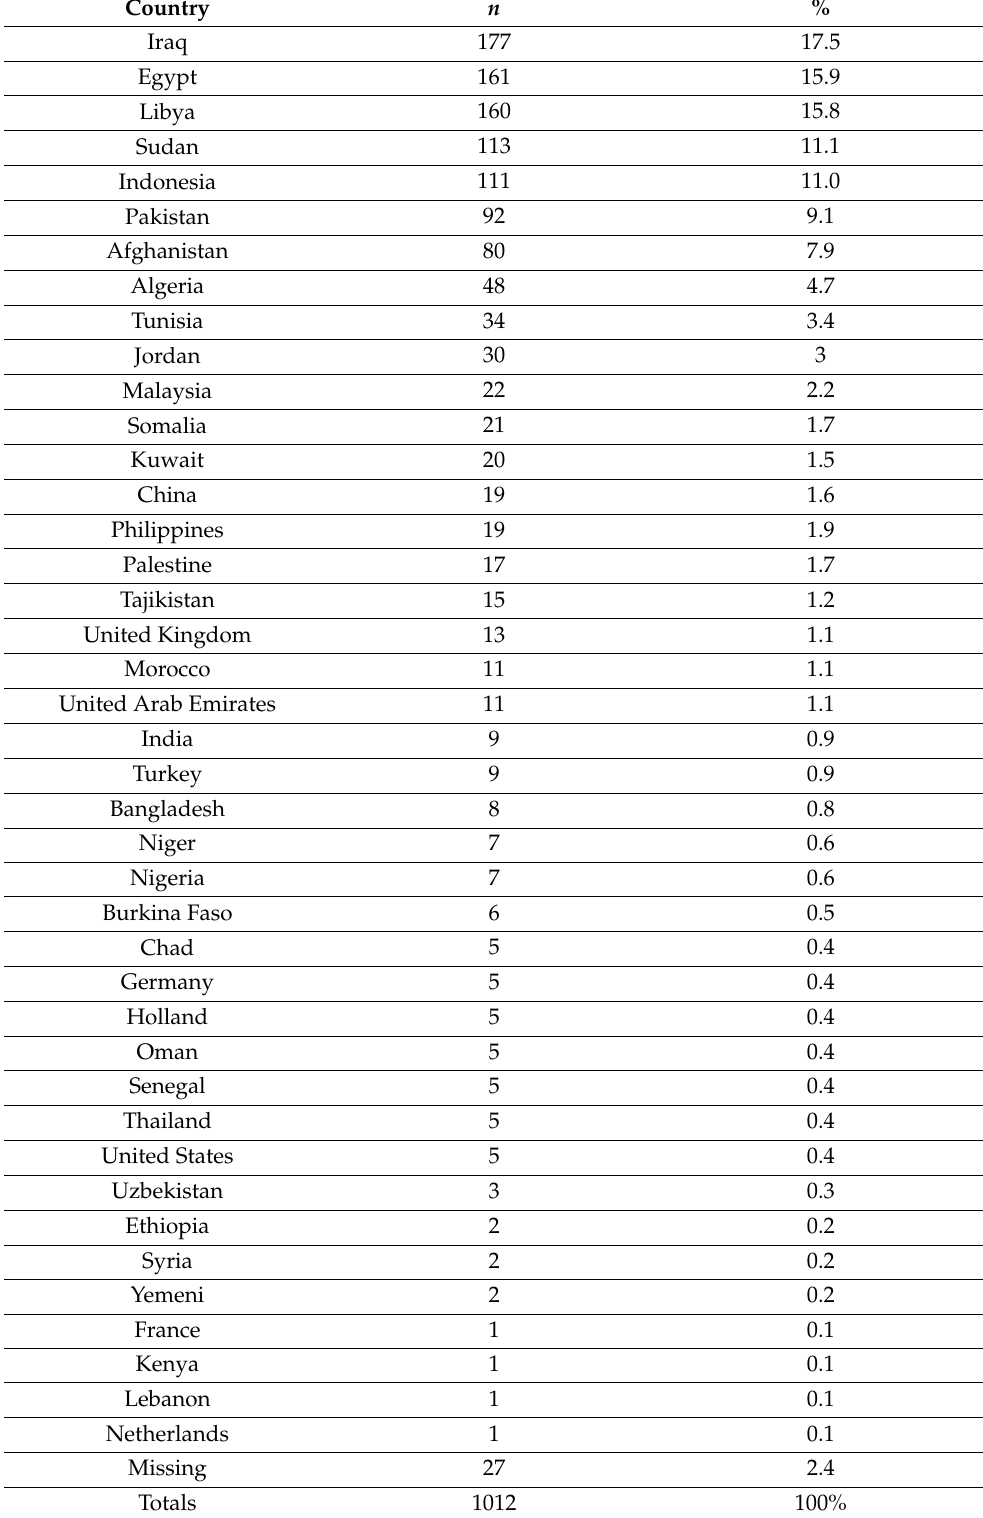
Table 2. Nationalities of respondent by